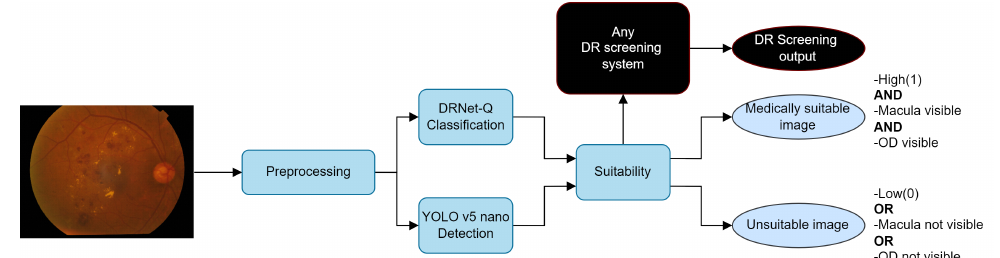
Figure 13. Suitability integration example in a DR system using